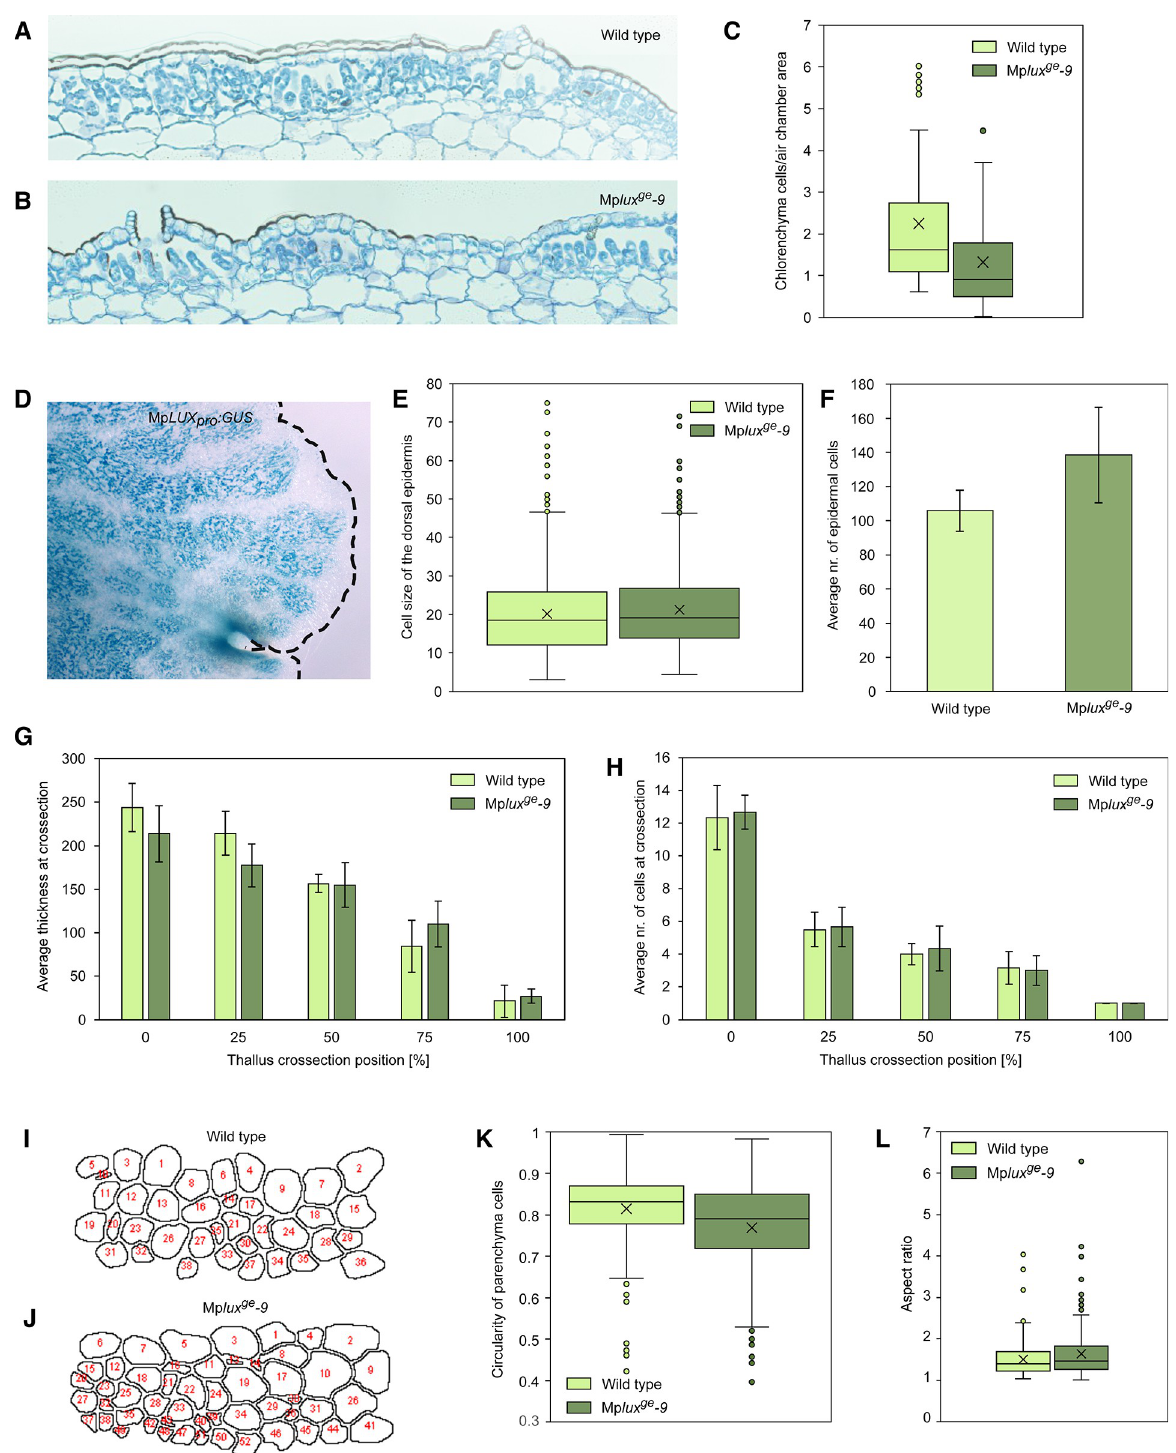
Fig 3. Differences in cell number, size and structure explain the growth phenotype of the Marchantia polymorpha lux ge knock-out mutant. (A,B) Micrographs of representative transverse sections displaying the number and size of dorsal epidermis, air pores, air chamber area and the underlying parenchyma in the wild type (A), and in Mp lux ge -9 (B). (C) Boxplot of chlorenchyma cells per air chamber area unit in wild type (number of analyzed air chambers, n = 60) and Mp lux ge -9 (n = 38). Two-tailed t-test, P = 0.0019. (D) Apical region of GUS-stained 3-week-old thallus from Mp LUX : GUS#7 . Dashed line indicates the thallus margin. (E) Boxplot showing the average dorsal epidermal cell width in wild type pro